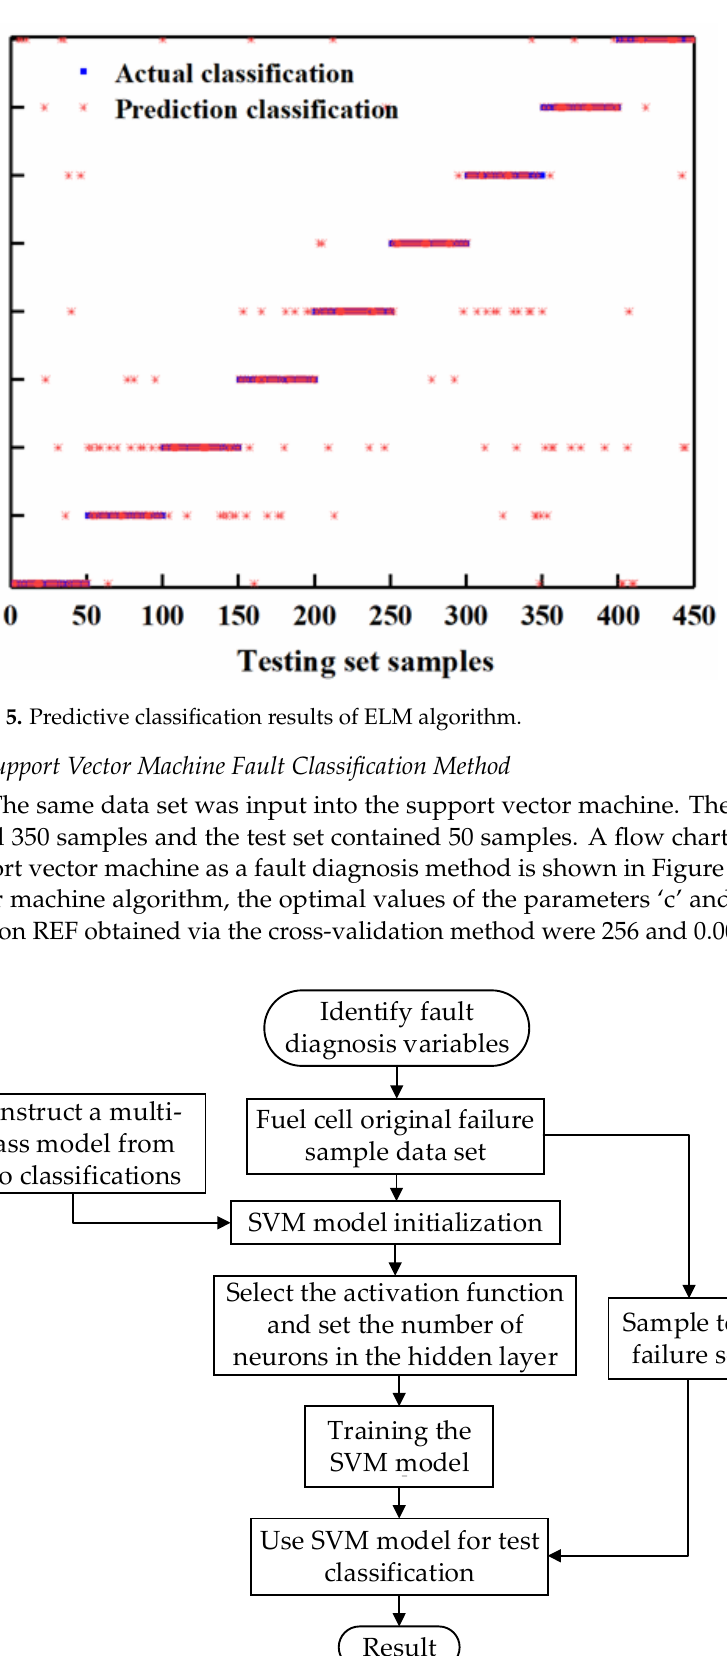
Figure 5. Predictive classification results of ELM algorithm.